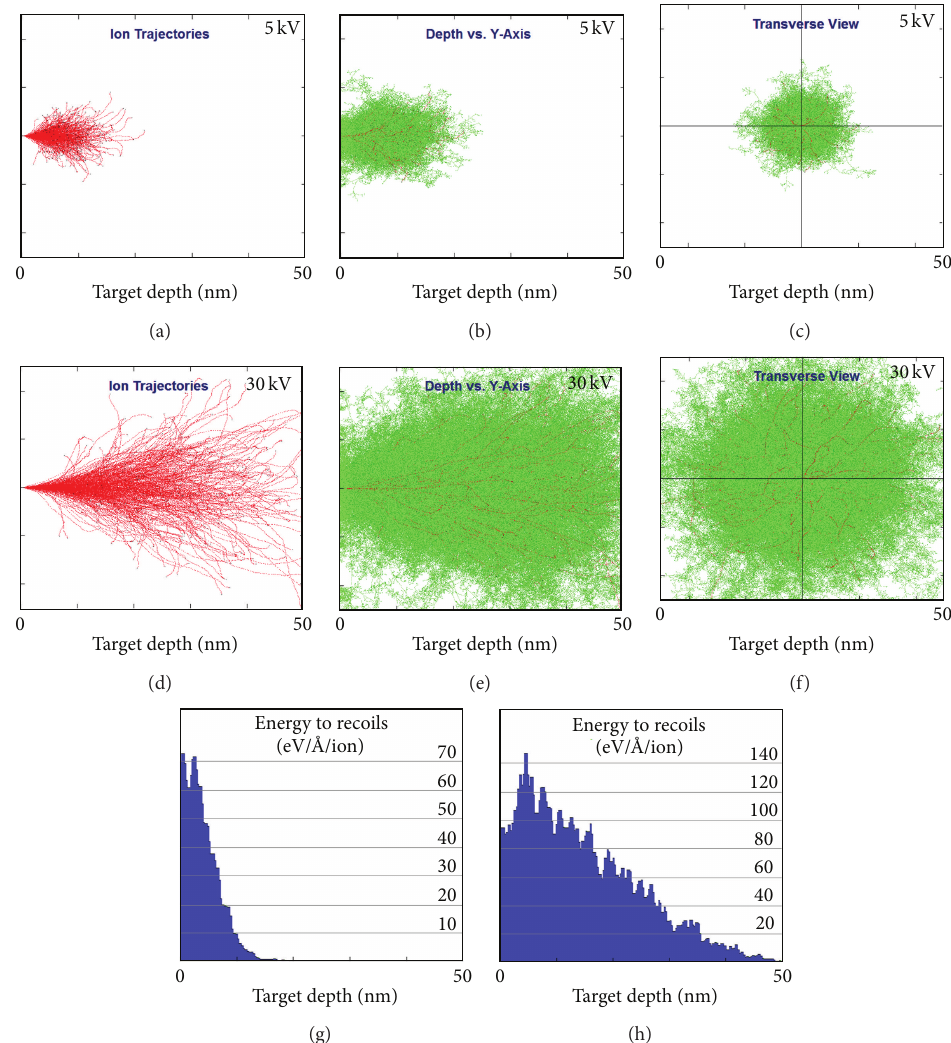
Figure 1: TRIM [4, 5] calculations show simulated collision cascades of 5kV and 30kV gallium ions in amorphous silicon (modeled with 2 eV lattice binding energy, 4.7 eV surface binding energy, and 15eV displacement energy). Plotted are 500 gallium ion trajectories in red, all entering normal to the surface at a single point, each as a single event and then superimposed. The green trajectories are of misplaced silicon atoms, which are plotted on top of the red ones in order to visualize the full volume where changes do happen due to the ion impact. Without taking into account actual gallium ion beam diameters, the simulated interaction volume is roughly 15nm diameter wide and 15 nm deep for 5 kV and 40 nm diameter wide and 50 nm deep for 30 kV gallium ions. The average distribution of deposited energy per ion is shown in (g) and